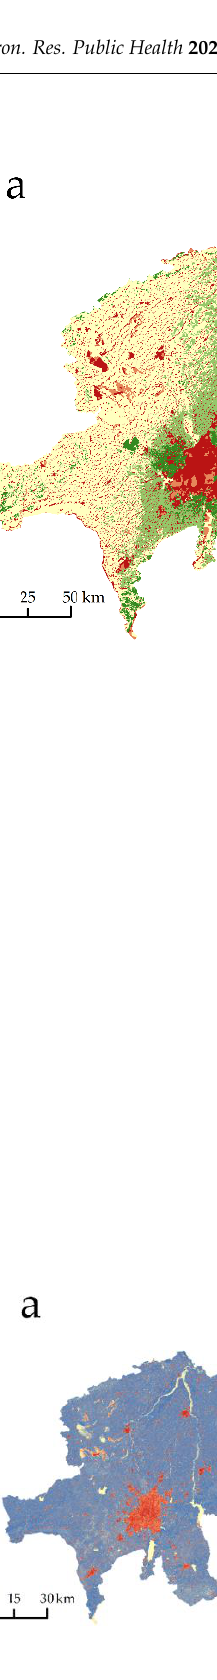
Figure 4. Ecological resistance surface. ( a ) Spatial distribution of the basic resistance surface. ( b ) The spatial distribution of nighttime light intensity (TLI). ( c ) The spatial distribution of the modified resistance surface.